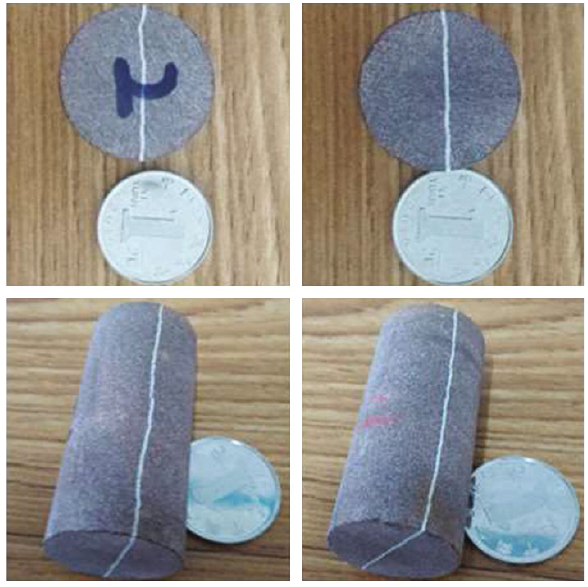
Figure 6: Tight sandstone core with a natural fracture.